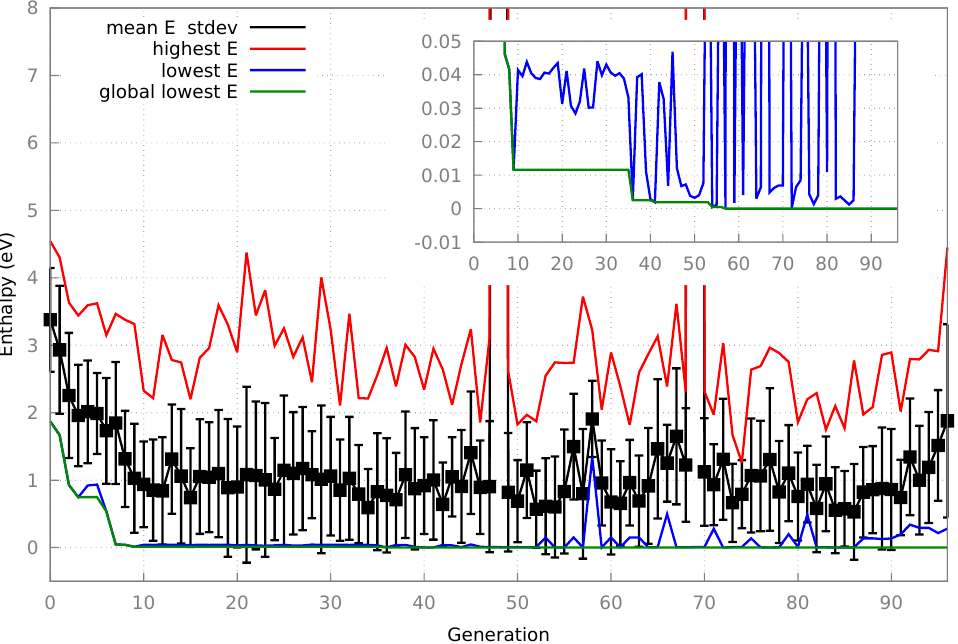
Figure 12. Total enthalpy per 12-atom cell of CFAS/Ge structure relative to the overall lowest enthalpy structure found. The lines represent the highest, lowest and mean enthalpies, along with the overall best structure found so far for each generation. The inset shows the best structures found in the 0–0.05 eV